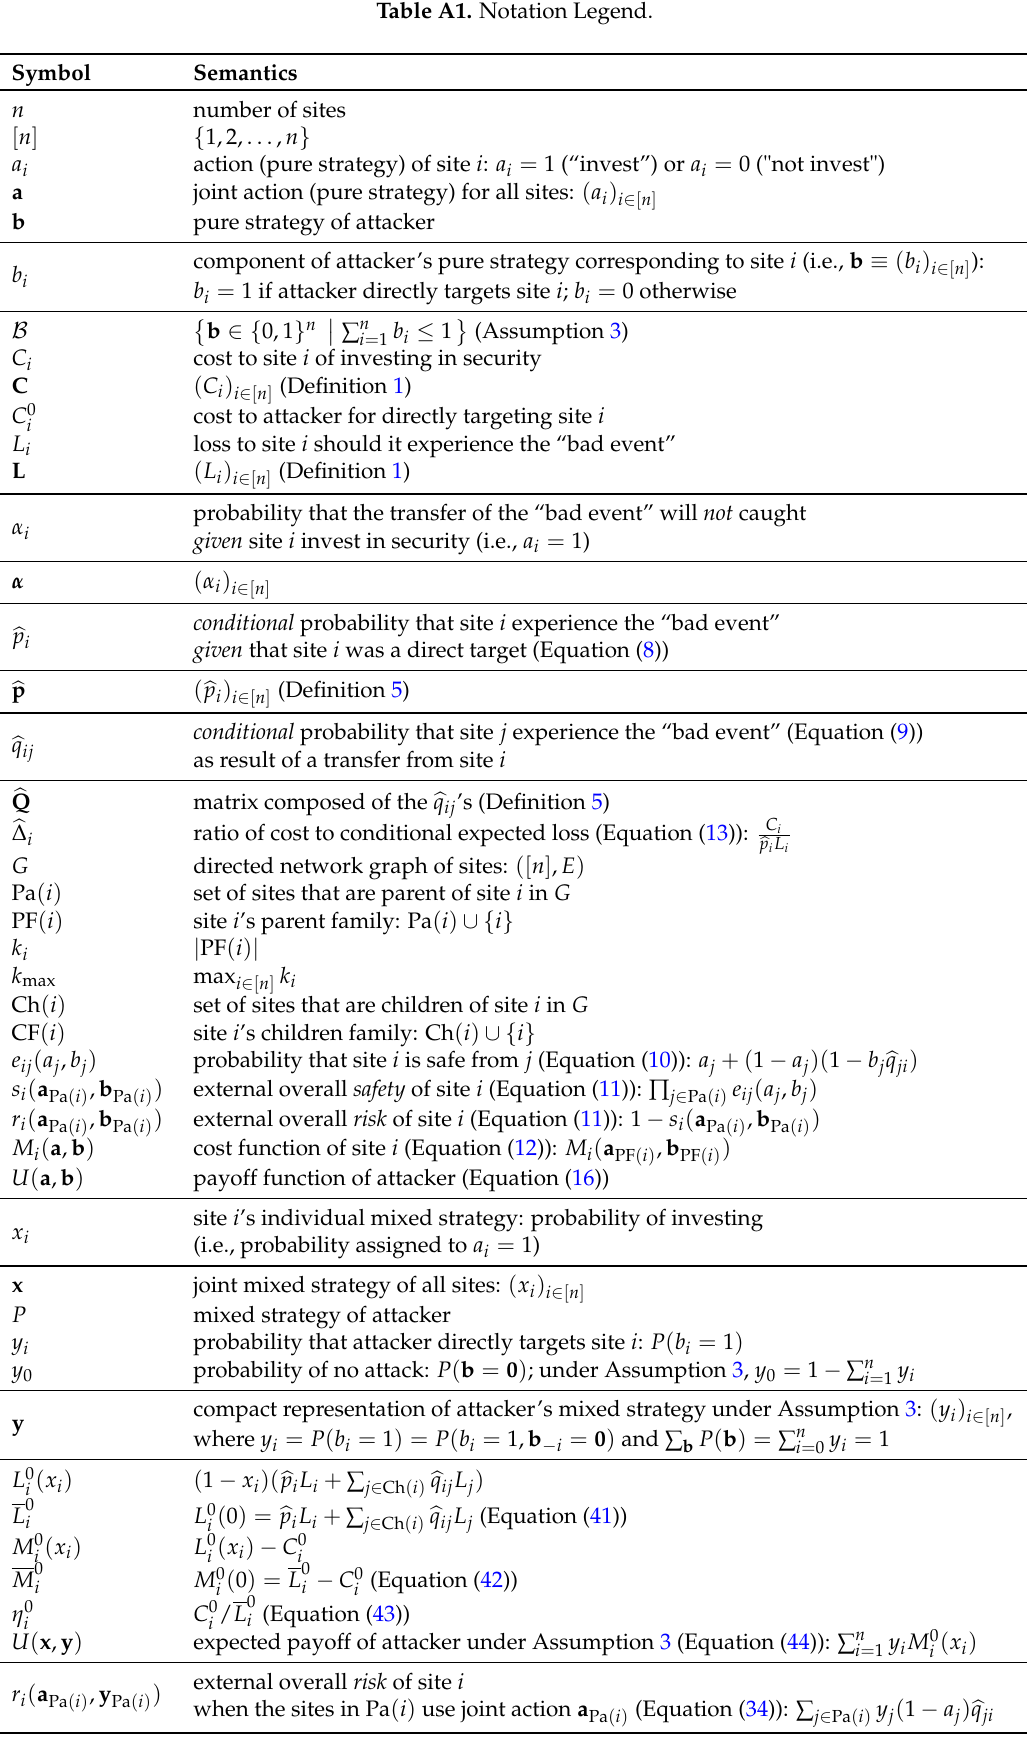
Table A1. Notation